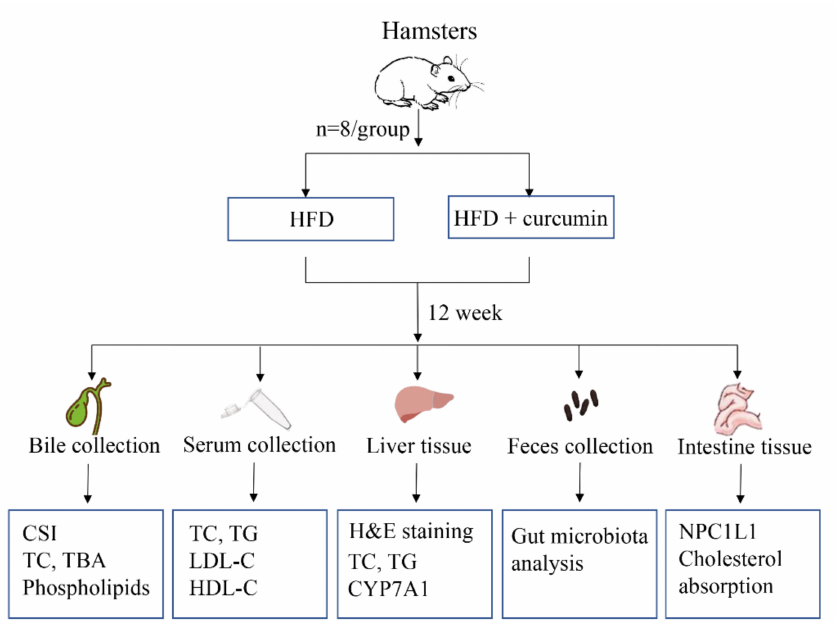
Figure 1. Experimental procedure. HFD, High-fat diet; CSI, Cholesterol saturation index; TC, Total cholesterol; TBA, Total bile acids; TG, Total triglycerides; LDL-C, Low-density lipoprotein cholesterol; HDL-C, High-density lipo-protein cholesterol; CYP7A1, Cholesterol 7-alpha hydroxylase; NPC1L1, Niemann–Pick C1-like protein